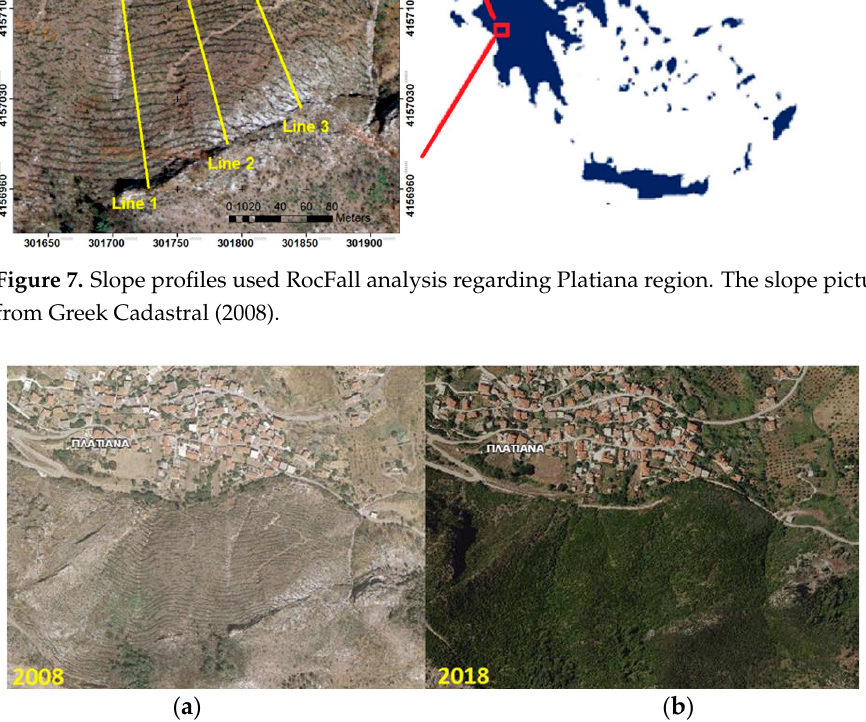
Figure 8. ( a , b ) The slope next to Platiana village before and after the reforestation procedures.